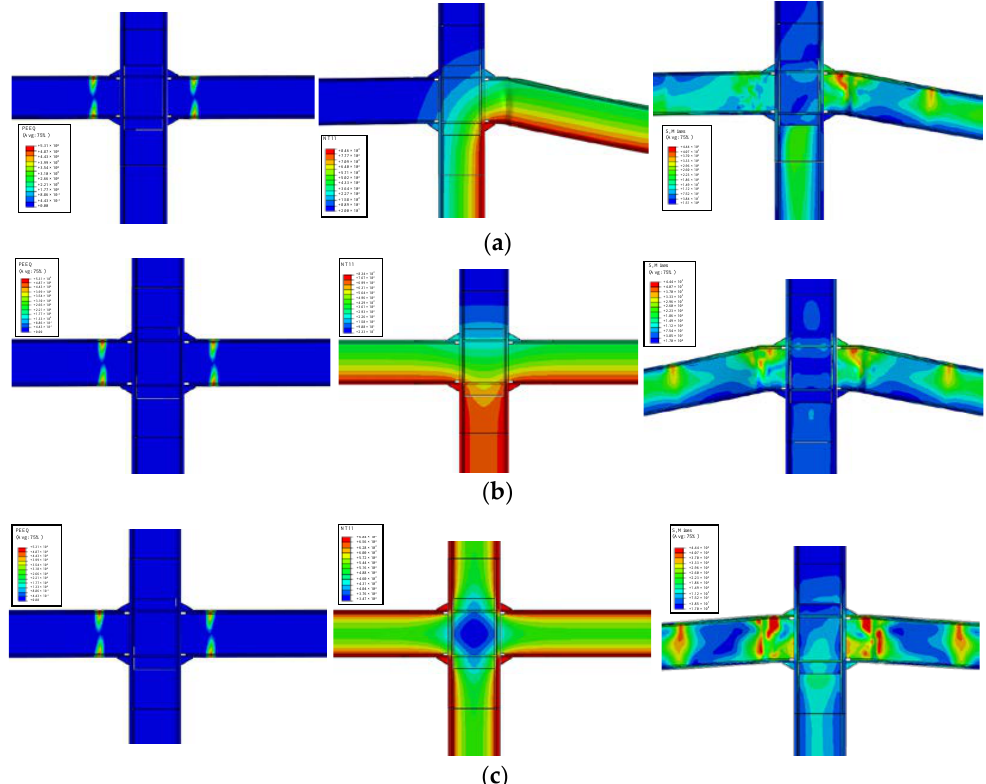
Figure 12. PEEQ, temperature, and Von Misses stress distributions of internal joints subjected to S1 ( a ), S2 ( b ), and S3 ( c ) fire scenarios.